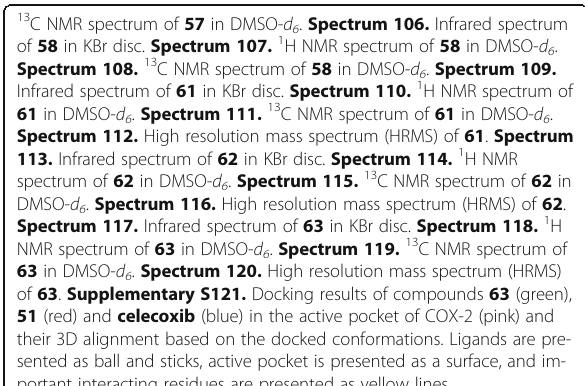
of 63 . Supplementary S121. Docking results of compounds 63 (green), 51 (red) and celecoxib (blue) in the active pocket of COX-2 (pink) and their 3D alignment based on the docked conformations. Ligands are pre- sented as ball and sticks, active pocket is presented as a surface, and im- portant interacting residues are presented as yellow